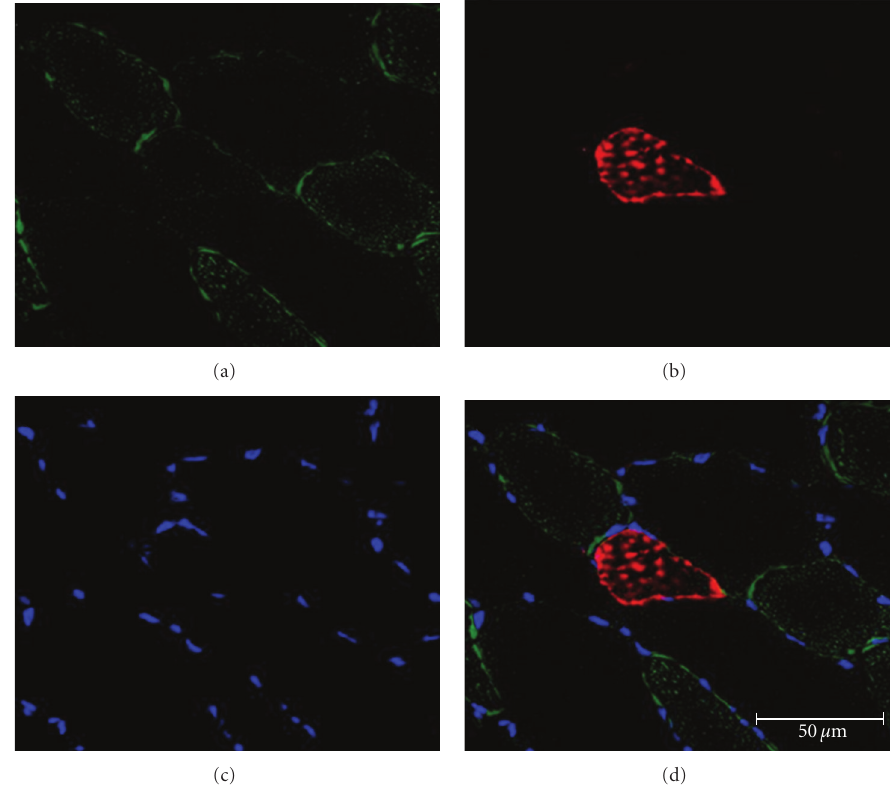
Figure 4: High-magnification image demonstrates the presence of LDs within nonslow muscle fibers in the cross section of the rat TA. (a) Fibers stained with BODIPY (green) demonstrate the appearance of spherical lipid droplets within the muscle fibers. (b) Slow fibers were identified using an antibody specific for the slow form of MHC (red). (c) Nuclei were stained with DAPI (Blue). (d) Merged triple label image of the muscle section demonstrates fibers presenting with substantial BODIPY signal that do not label for slow MHC. All images were taken at 63x, and a scale bar is provided for